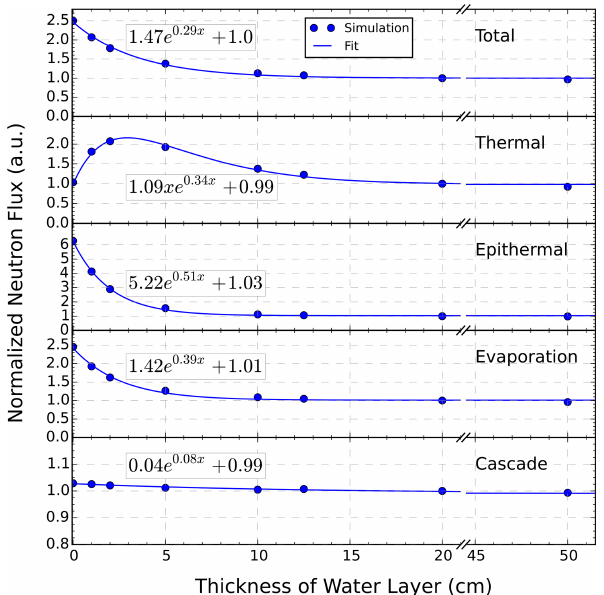
Figure 4. Neutron flux as a function of thickness of water layer on dry limestone soil at 2661.5ma.s.l., for horizontal geometry and for different neutron energy ranges (thermal: E < 0 . 4eV; epither- mal: 0.4eV ≤ E < 100keV; evaporation: 100keV ≤ E < 20MeV; cascade: E ≥ 20MeV; and total). Solid lines represent fits of the data points using a function of ae − bx + c for epithermal, evapora- tion, and cascade neutrons and axe − bx + c for thermal neutrons.